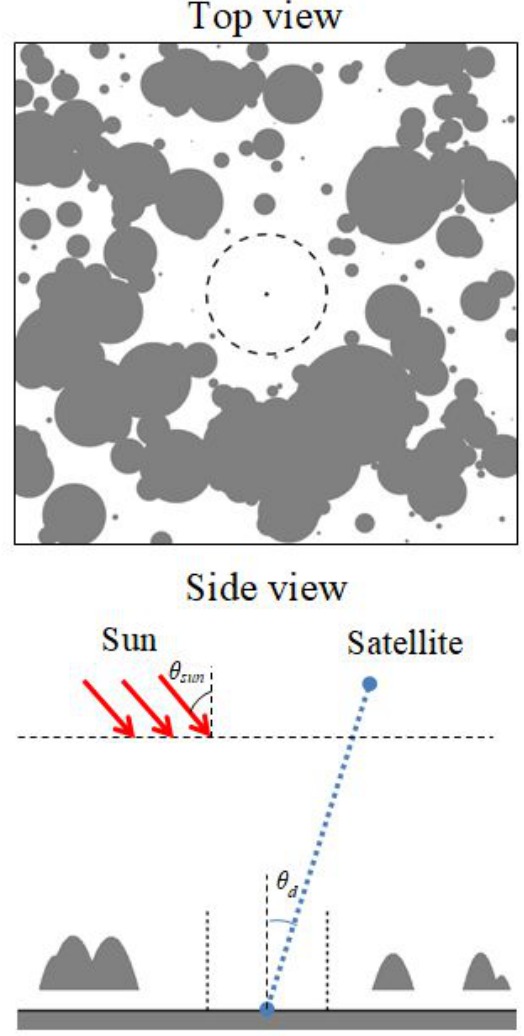
Figure 1. Geometric of the